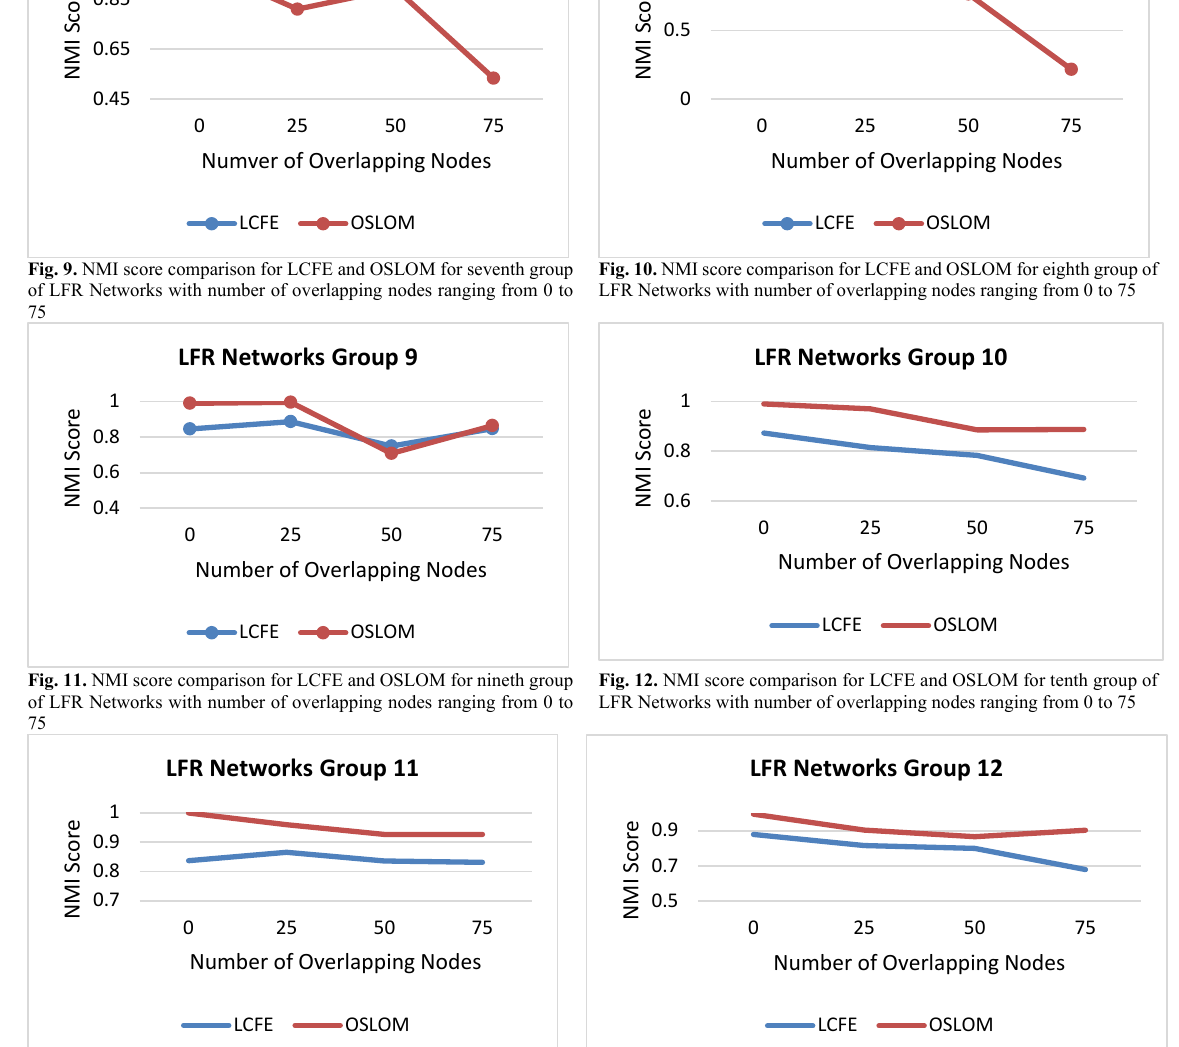
Fig. 13. NMI score comparison for LCFE and OSLOM for eleventh group of LFR Networks with number of overlapping nodes ranging from 0 to 75